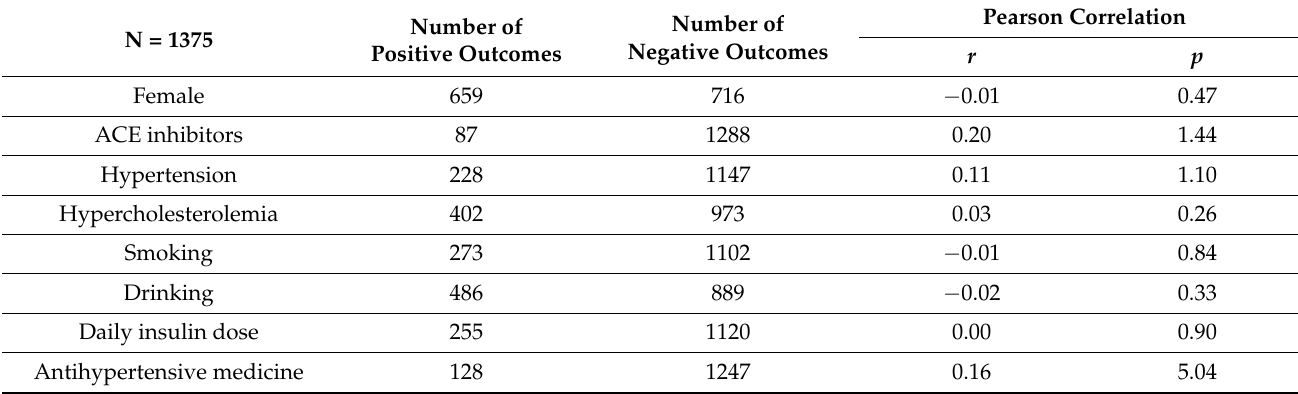
Table 2. Baseline characteristics of EDIC patients (categorical